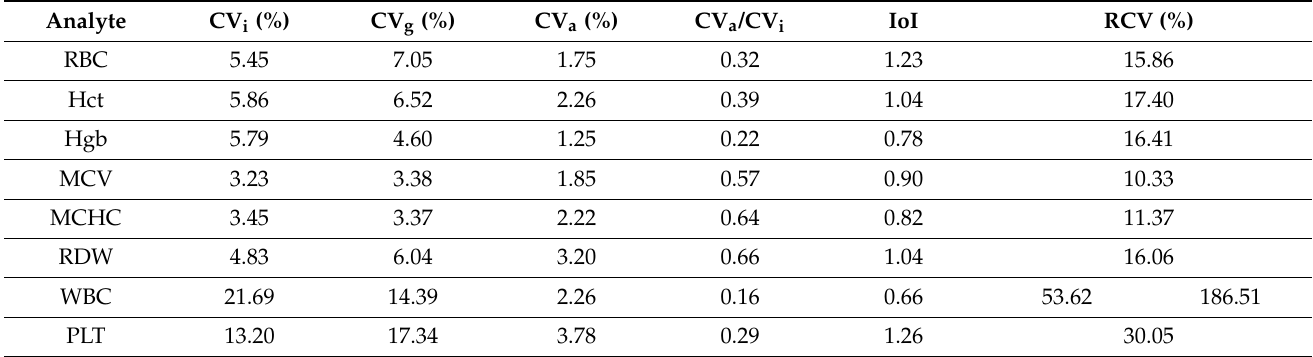
Table 3. Coefficients of variations (CVs), index of individuality (IoI), and reference change value (RCV). CV g = between-animals coefficient of variation, CV i = within-animal coefficient of variation, CV a = analytical imprecision. RBC = number of erythrocytes, Hct = hematocrit, Hgb = hemoglobin, MCV = mean cellular volume, MCHC = mean cellular hemoglobin content, RDW = red blood cell distribution width, WBC = number of leukocytes, PLT = number of platelets.